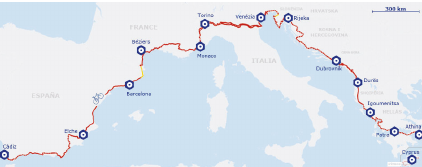
Figure 2: EuroVelo 8 bicycle route (source: http://www.eurovelo8